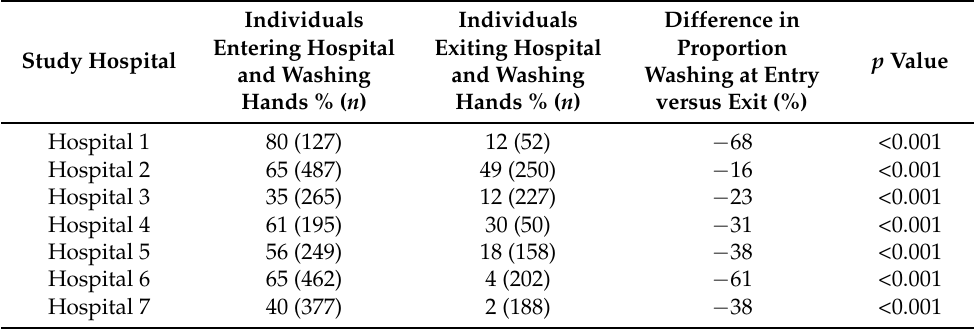
Table 3. Observed hand hygiene behavior at hospital entry and exit handwashing stations in 7 Liberian hospitals, 2020. Significance of differences tested using